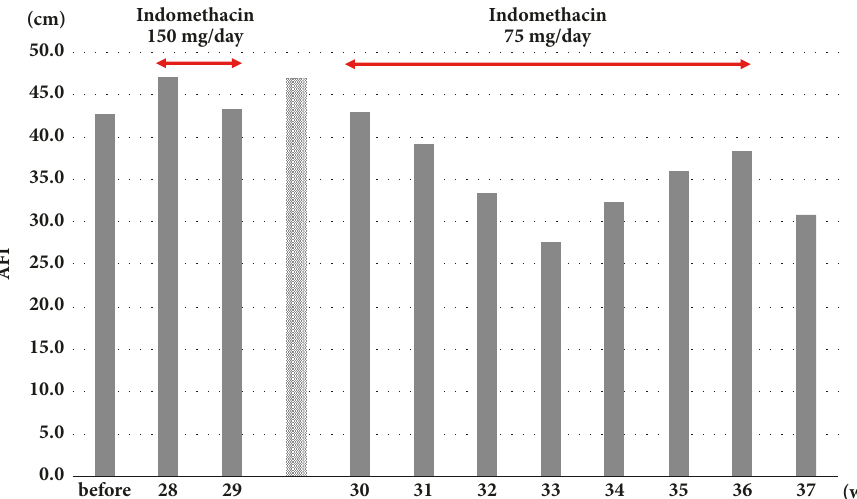
Figure 1: Amniotic fluid index (cm). The data are weekly averages. The data in the gray bar are corrected at 29 weeks and 6 days of gestation.